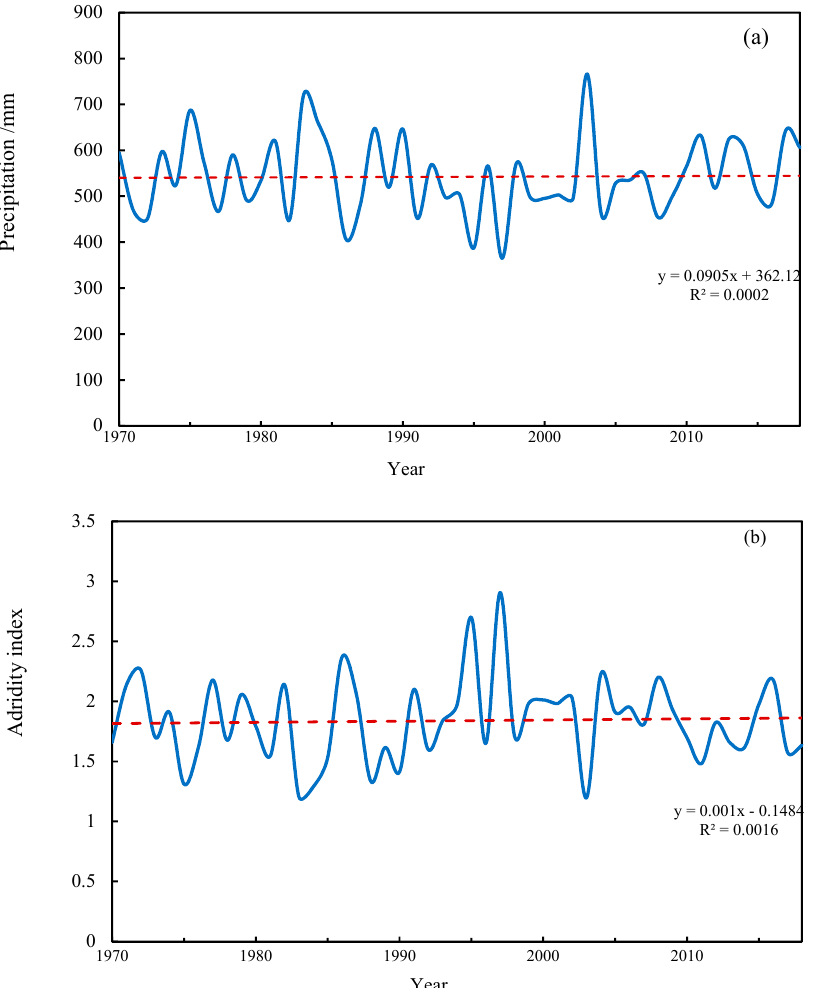
Figure 9. Variation of average precipitation and Adridity index from 1960–2018 in Weihe River Basin. ( a ): average precipitation; ( b ): Adridity index.